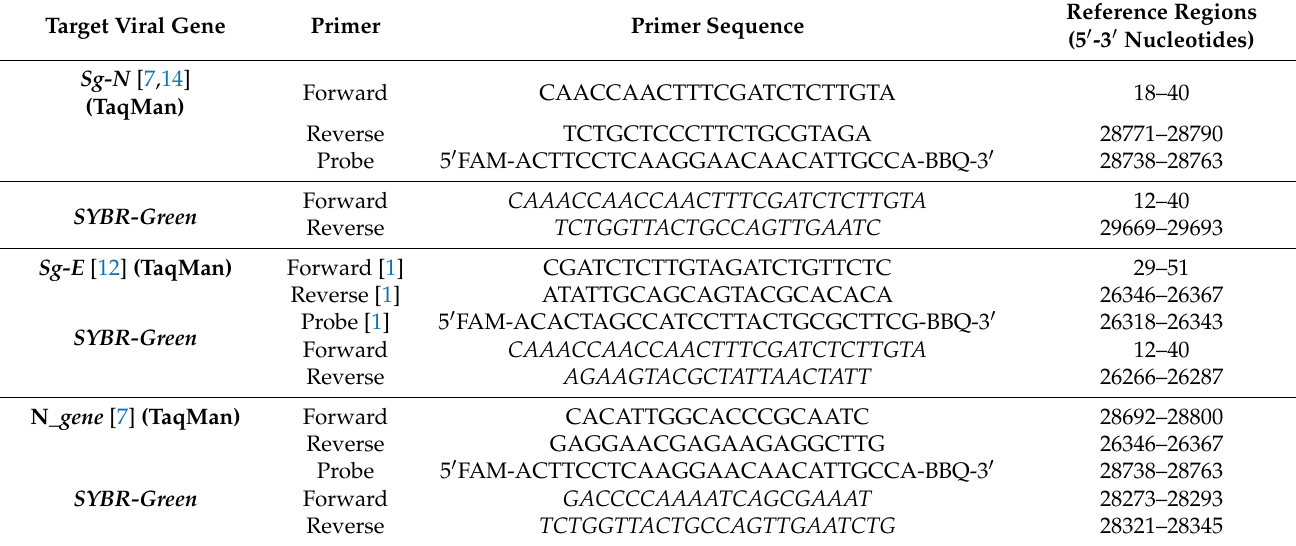
Table 3. Primers for sgRNA detection by real-time PCR.